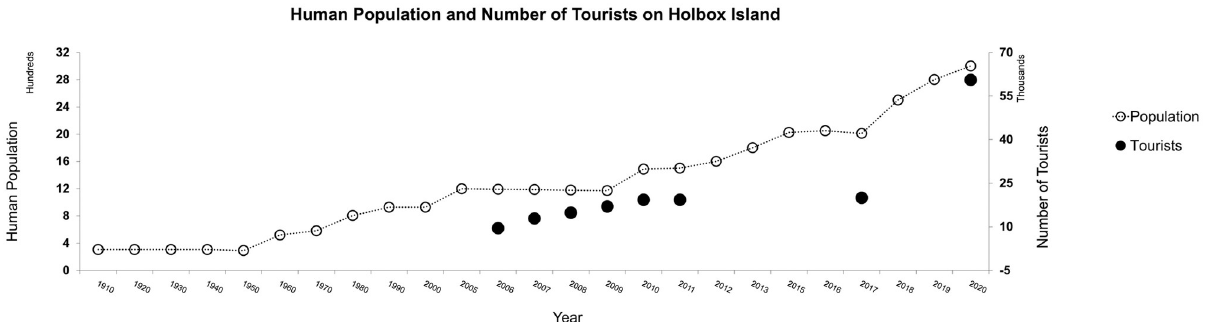
Fig 3. Holbox human population and available data for tourists’ numbers.